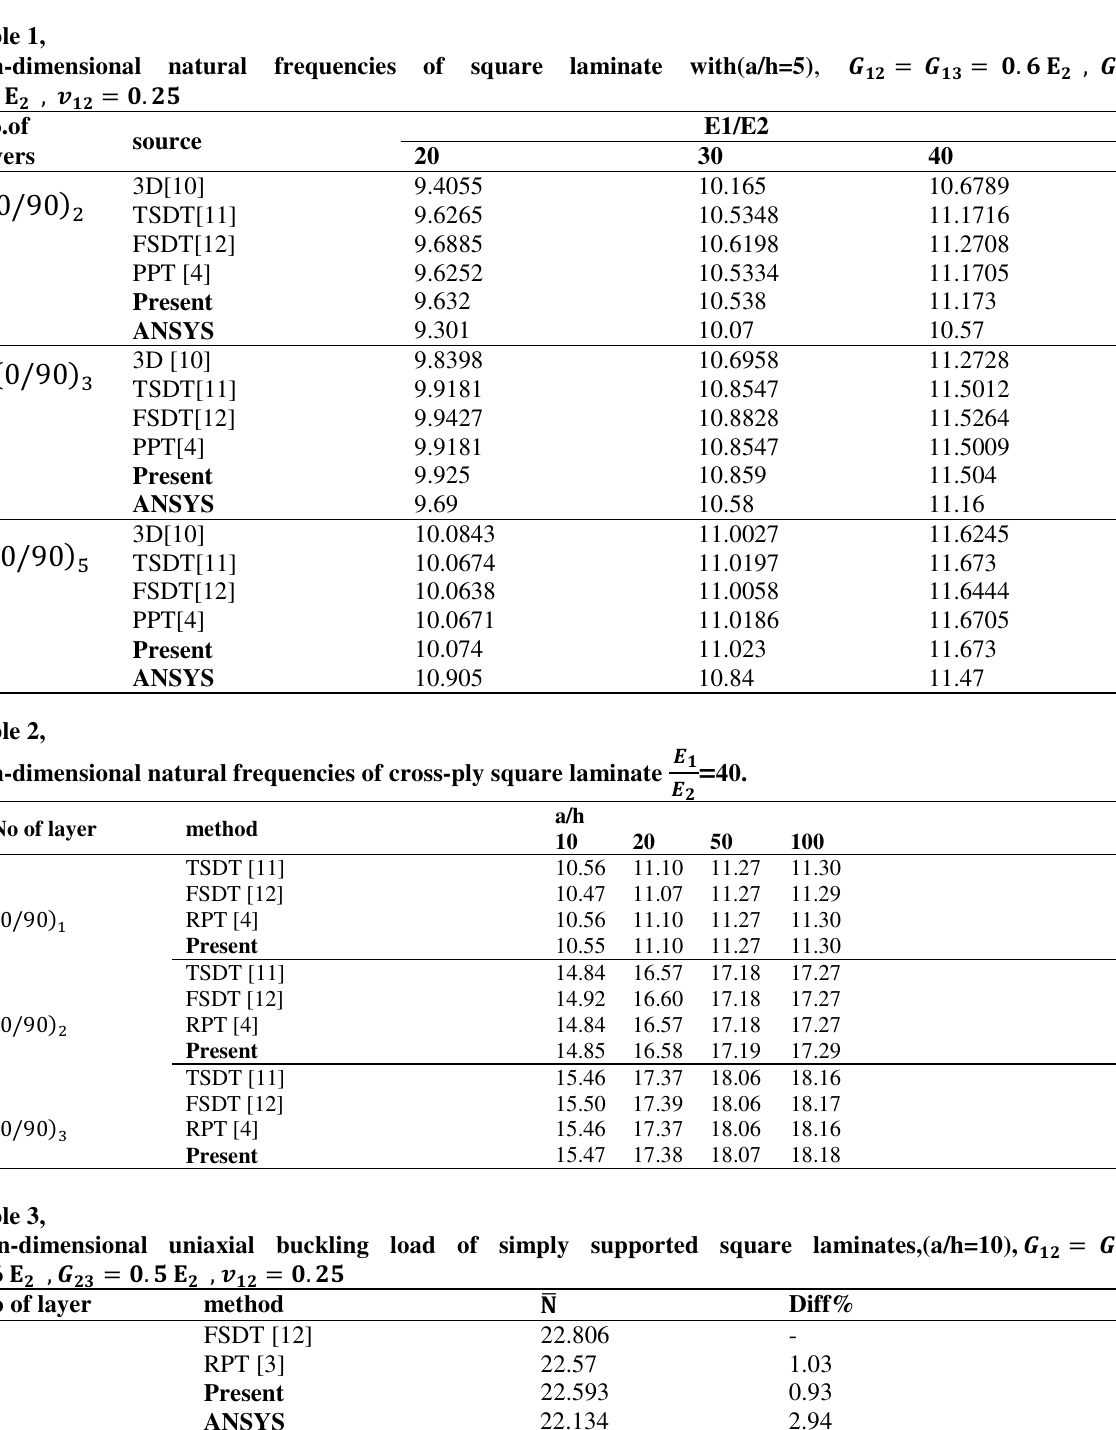
Non-dimensional natural